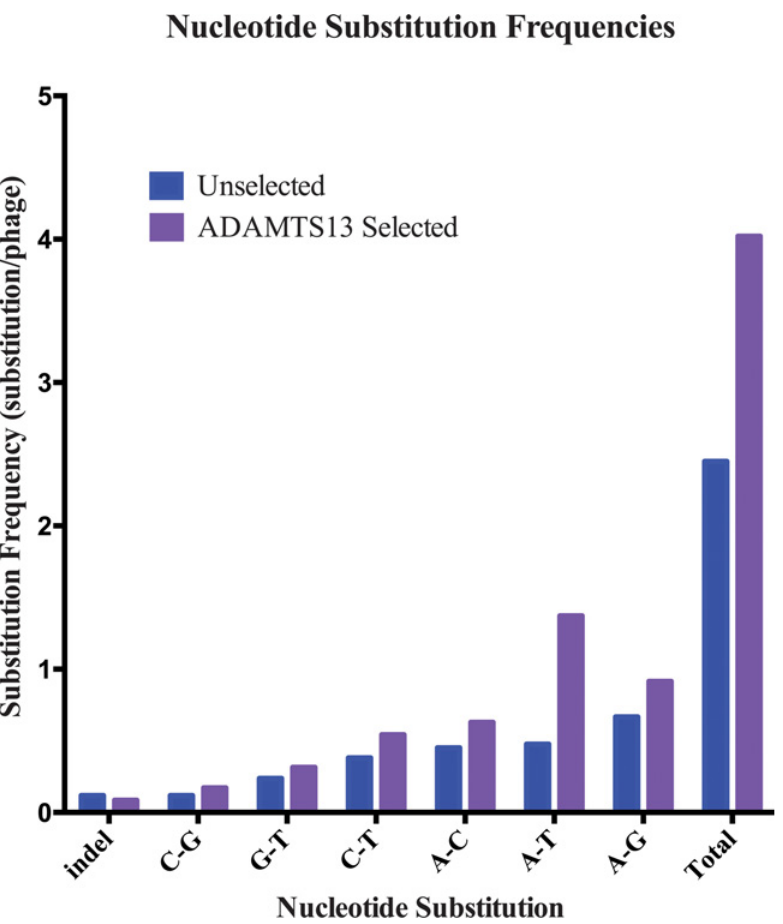
Fig 2. Mutation frequency in unselected and selected libraries. VWF73 encoding sequences (219 bp) from ADAMTS13 selected phage were compared to VWF73 encoding sequences from unselected phage derived from the same original library. There were 103 nucleotide changes in the 42 phage (2.45/phage) sequenced in the unscreened library compared to 141 mutations in 35 phage (4.03/phage) sequenced after selection by ADAMTS13. Sequences were aligned and mutations were binned into the substitution class using the MegAlign program. To obtain the number of substitutions per sequenced phage, the total number of mutations in each substitution class was divided by the number of phage sequenced in the unselected library (42) or the selected library (36).